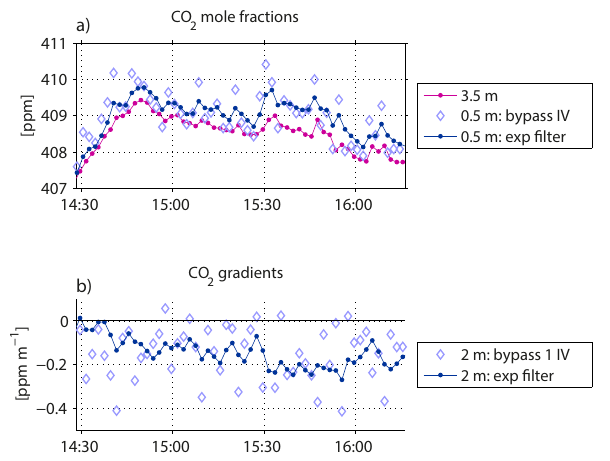
Figure 4. Nulling procedure example for 2 August 2011. Around 05:50 local time, the nulling valves were activated to draw air through the nulling volume (flushed for 40min prior) each of the four gas lines that were usually connected to the 28, 24, 3.5, and 0.5m inlets. The full CO 2 time series (upper plot) shows that it took over 20min to flush the integrating volumes and sample lines of the memory of the strong nighttime CO 2 mole fraction gradient. Over the procedure, each inlet was sampled twice for H 2 (lower right) and eight times for CO 2 (lower left, shaded portion upper plot) and H 2 O (not shown). Second-order polynomials were used to detrend the data to remove the drift in mole fractions of CO 2 and H 2 over the nulling period.